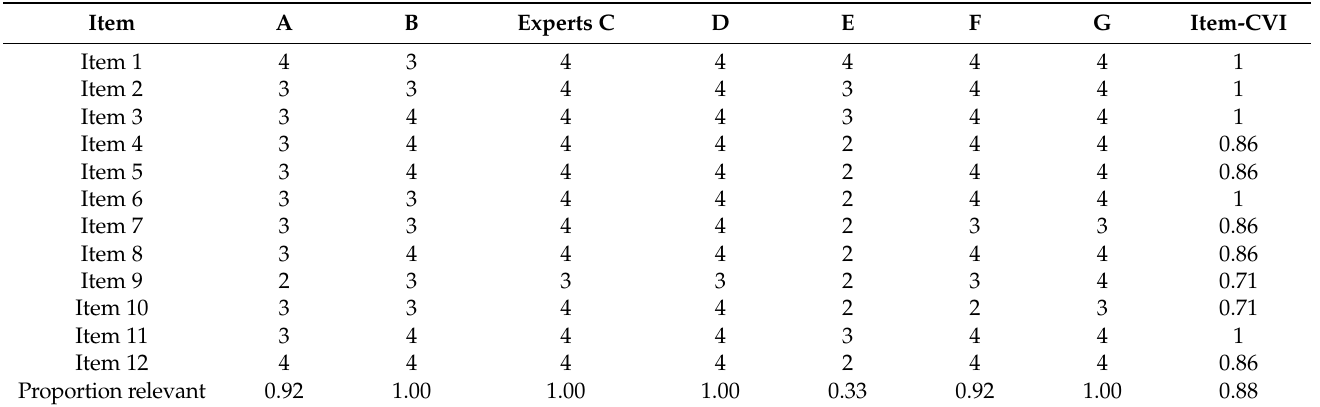
Table A1. Content validity indexes of the MEQ-C-C.